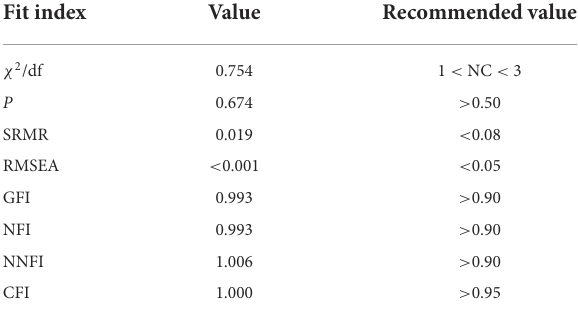
TABLE 6 Goodness-of-fit indices for the